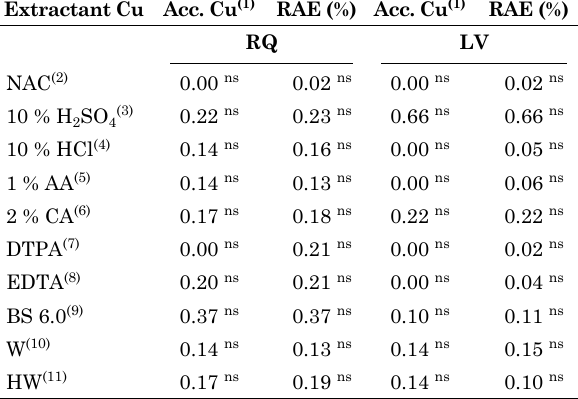
Table 7. Linear correlation coefficients (R) between the amount of Cu potentially available according to the solubility of the sources in each extractant and Cu accumulation in wheat plants and the relative agronomic efficiency (RAE) of the sources, in RQ (sandy) and LV (clayey)